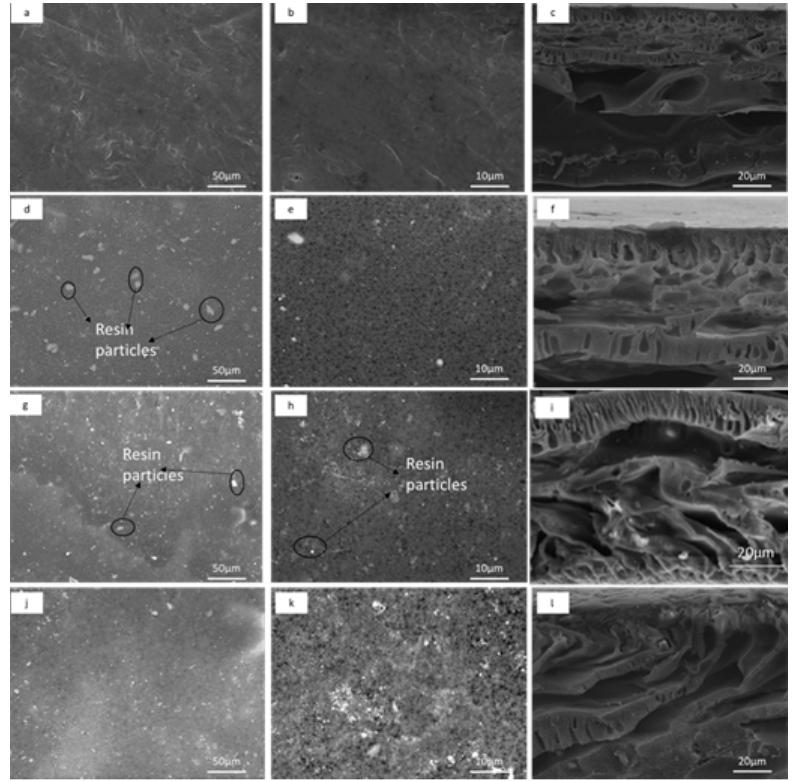
Figure 2. SEM images of bare PES and heterogeneous CEMs: ( a ) surface images of bare PES at ×500, ( b ) surface images of bare PES at ×1000, ( c ) cross-sectional images of bare PES, ( d ) surface images of CEM-1 at ×500, ( e ) surface images of CEM-1 at ×1000, ( f ) cross-sectional images of CEM-1, ( g ) surface images of CEM-2.5 at ×500, ( h ) surface images of CEM-2.5 at ×1000, ( i ) cross-sectional images of CEM-2.5, ( j ) surface images of CEM-1 at ×500, ( k ) surface images of CEM-3.5 at ×1000, and ( l ) cross- sectional images of CEM-3.5.